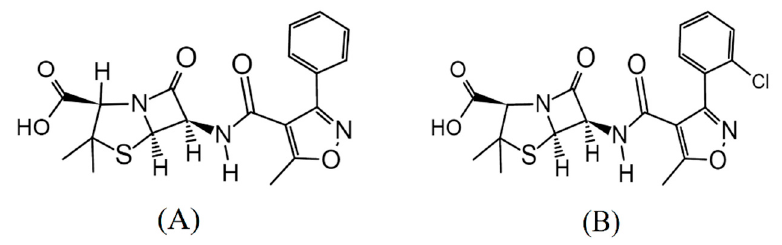
Figure 1. Structure of oxacillin ( A ) and cloxacillin ( B ).